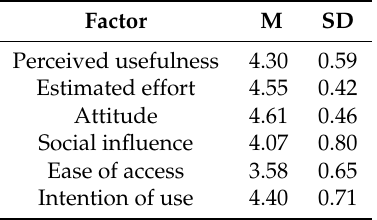
Table 2. Mean (M)/Standard Deviation (SD) Values for each Selected Factor.